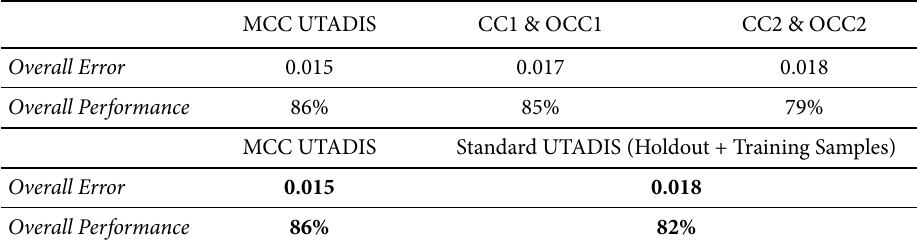
table 5. Overall error and performance values for the